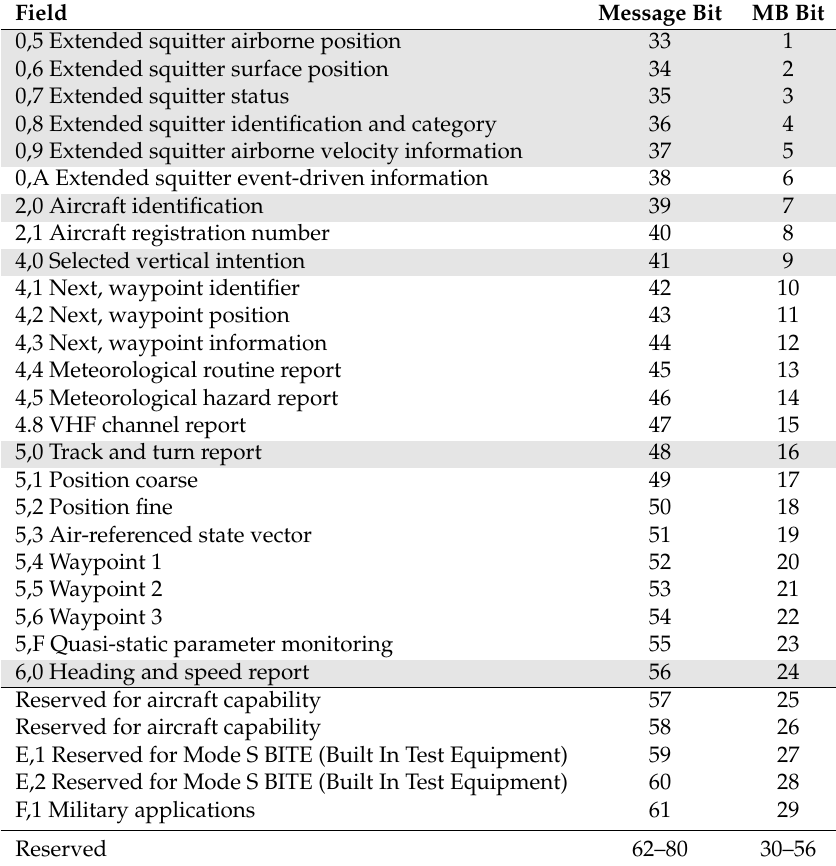
Table 2. Common usage GICB capability reports (BDS1,7), MB field (rows with gray color are common ADS-B, ELS, and EHS